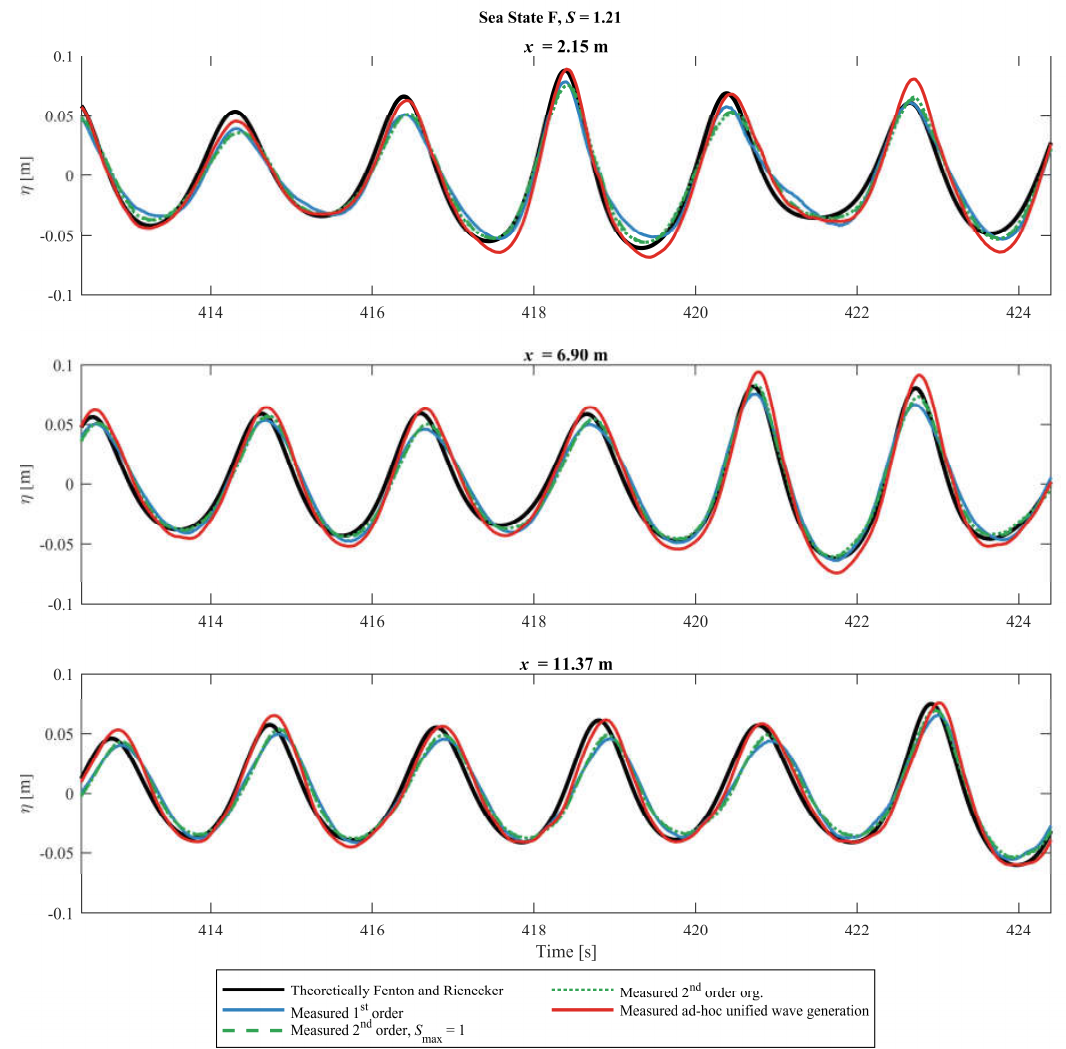
Figure 11. Numerically surface elevation compared with the first-order, second-order, modified second-order and the ad-hoc unified wavemaker methods for Sea State F.